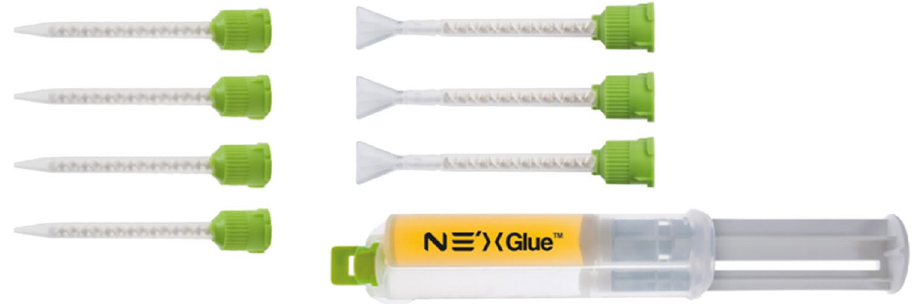
Figure 1. Photo of NE’X